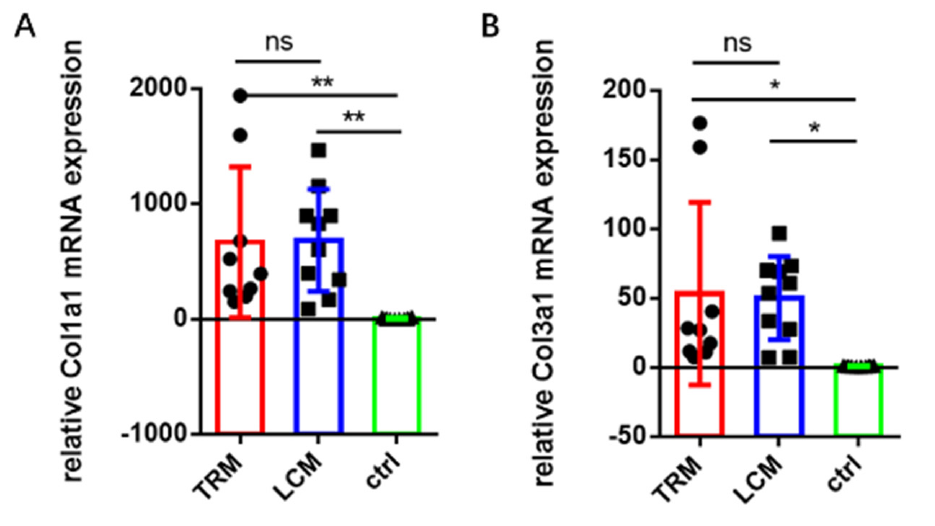
Figure 4. Relative mRNA expression of collagens related to tendons in the three groups. ( A , B ) Relative mRNA expression of collagen I and III. Mean ± SD, * p < 0.05; ** p < 0.01; ns, no significance.